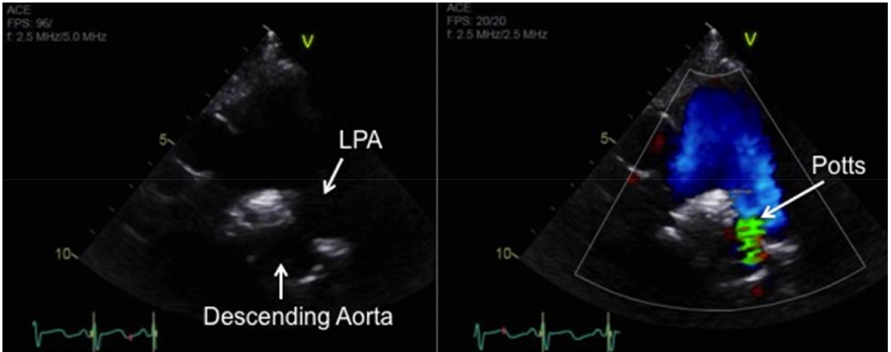
Figure 16. Echocardiogram of the Potts shunt in a patient with severe IPAH by 2D imaging ( left ) and with color Doppler ( right ). LPA, left pulmonary